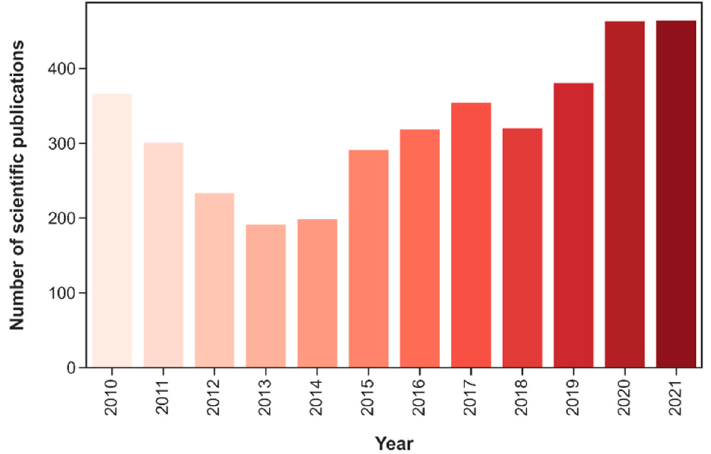
Figure 5. Number of scientific publications in the domain of e-fuel technology. (Note: The x-axis represents the publication year, while the y-axis represents the number of scientific publications).